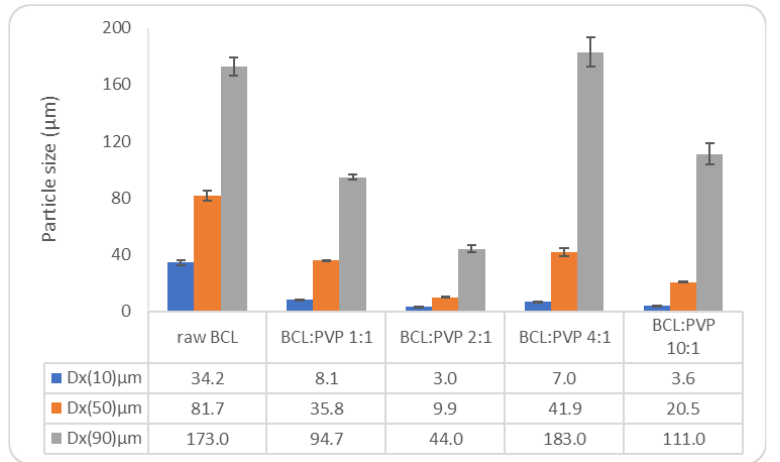
Figure 1. Particles sizes of raw bicalutamide, 1:1, 2:1, 4:1, and 10:1 solid dispersions. The results were obtained for freshly prepared powder samples.